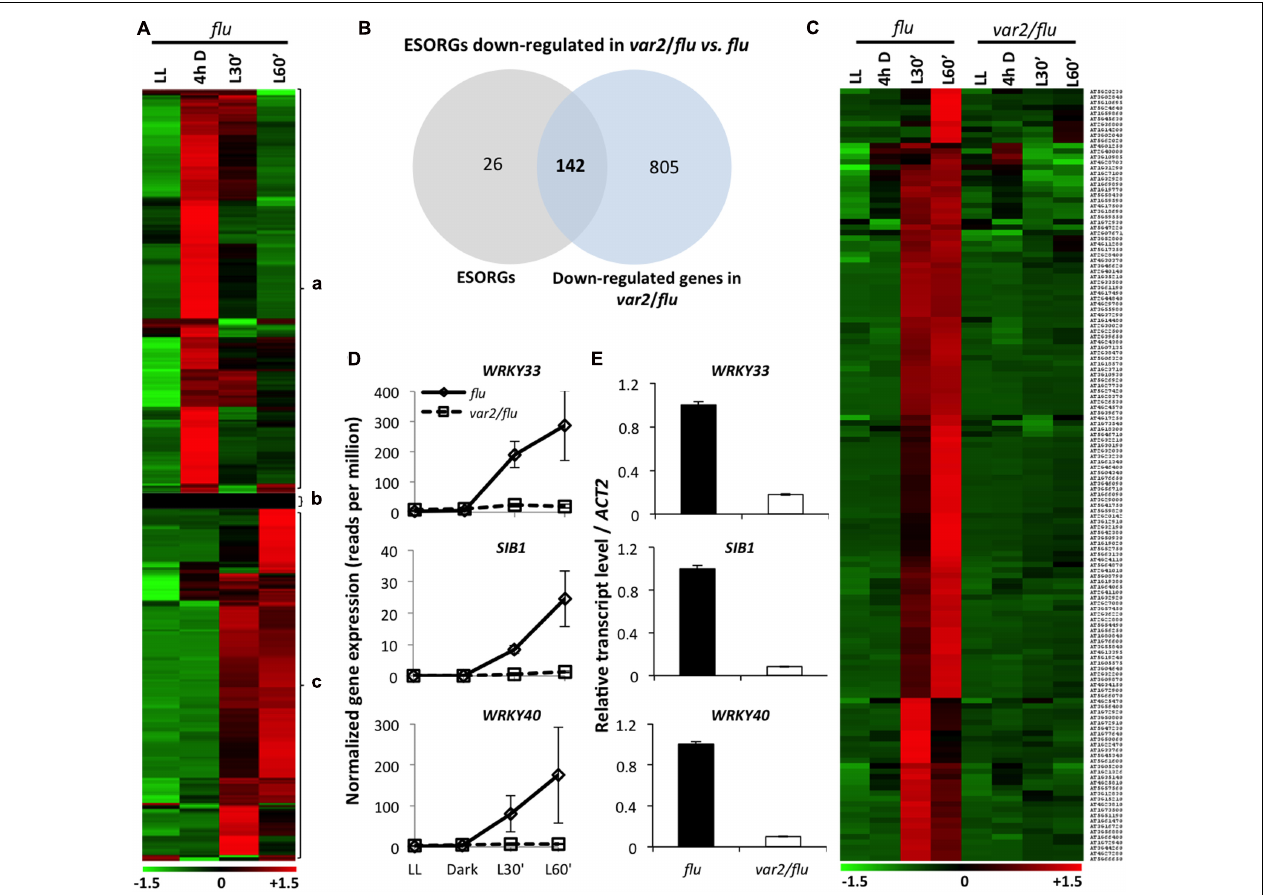
FIGURE 1 | FtsH2 is an integral component of EX1-mediated 1 O 2 signaling. RNA- seq-based comparison of gene expression was performed in 5-day-old var2/flu and flu seedlings that were initially grown under continuous light (LL), transferred to dark for 4 hours (4 h D), and then re-exposed to light for 30 (L30 (cid:48) ) and 60 min (L60 (cid:48) ). (A) Heat map reclassified the expression of previously reported SORGs. After excluding 215 genes induced during dark incubation (a) and 26 genes that either exhibited no expression or were not expressed differentially (b), 168 true ESORGs (c) were identified. (B,C) Venn diagram and heat map revealed that the majority (142 genes; 85%) of ESORGs were downregulated in var2/flu in comparison to flu upon dark-to-light shift. (D) Expression of 1 O 2 -specific and EX1/EX2-dependent genes SIB1 , WRKY33 and WRKY40 in var2/flu and flu . The average values and standard error of the normalized gene expression (reads per million; rpm) of three independent biological samples obtained by RNA-seq analysis were shown. (E) Validation of RNA-seq using those selected genes (D) by qRT-PCR. Results represent means of three independent biological replicates. Actin2 was used as a control for